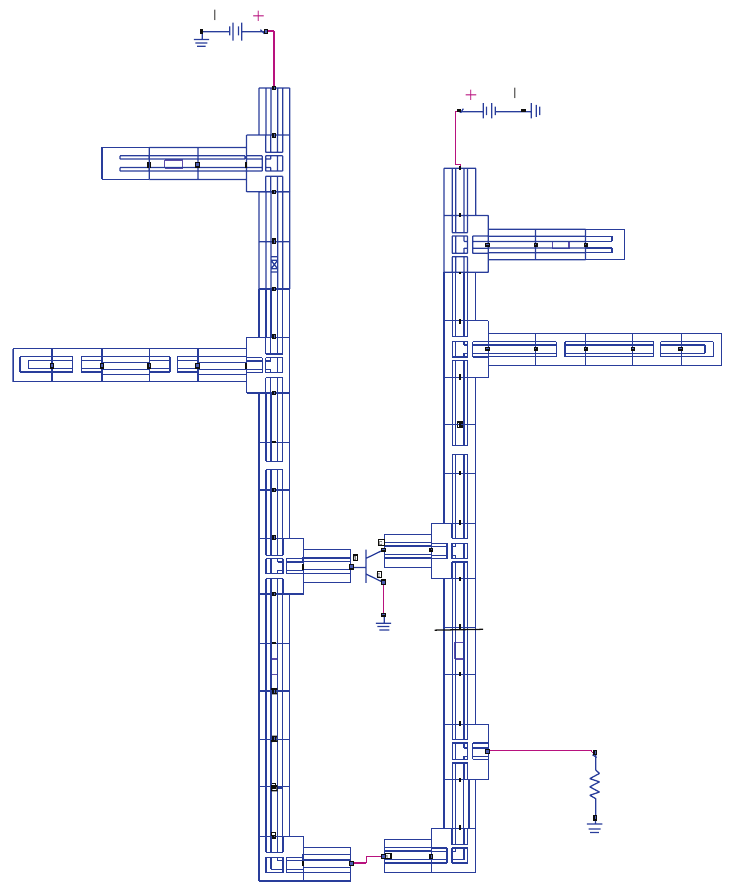
Figure 15: First oscillator circuit.